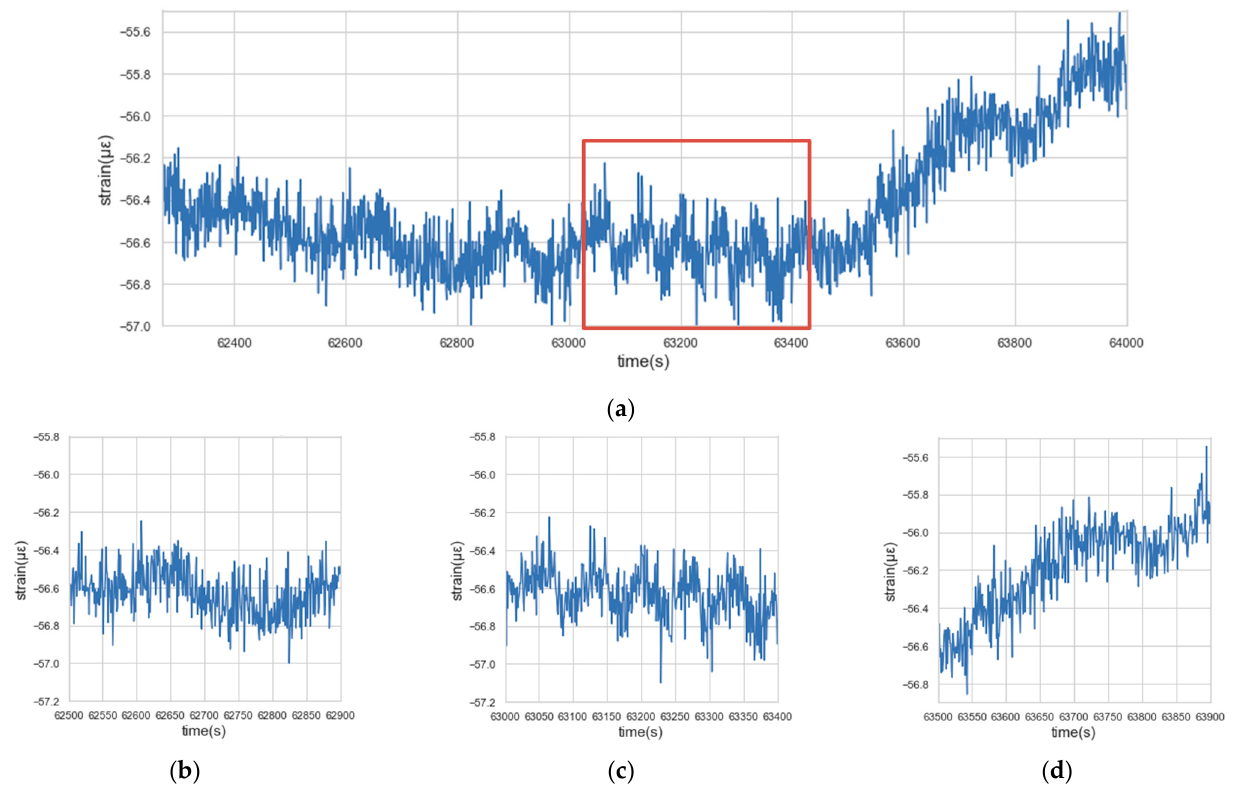
Figure 7. Collective anomaly: ( a ) Collective anomaly (a global view); ( b ) Before the anomaly; ( c ) The anomaly; ( d ) After the anomaly.